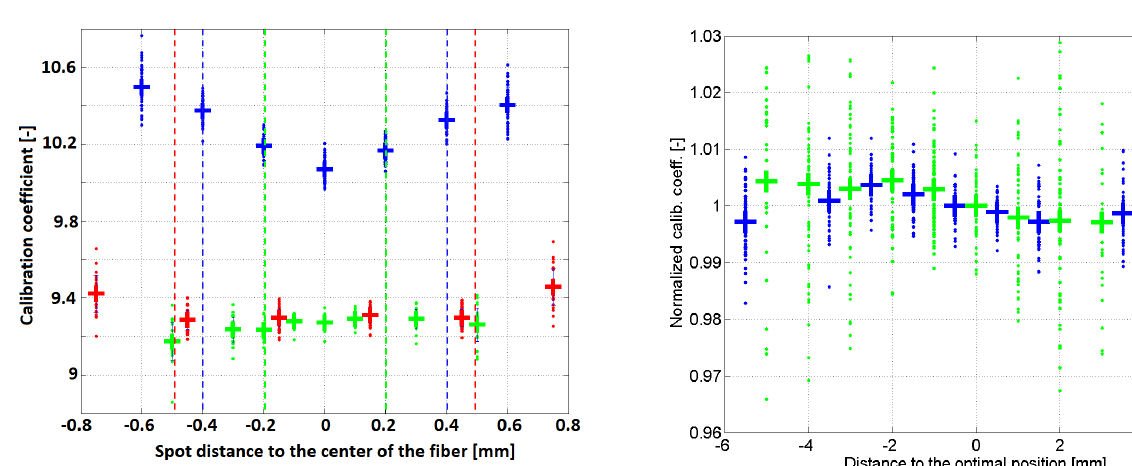
Figure 7. Normalized calibration coefficient as a function of dis- tance between the light source and fiber input (test no. 3 in Fig. 4) for two optical configurations of the receiving module: (blue) initial configuration (similar to the DEMEVAP campaign), and (green) op- timized configuration no. 1 (0.4mm